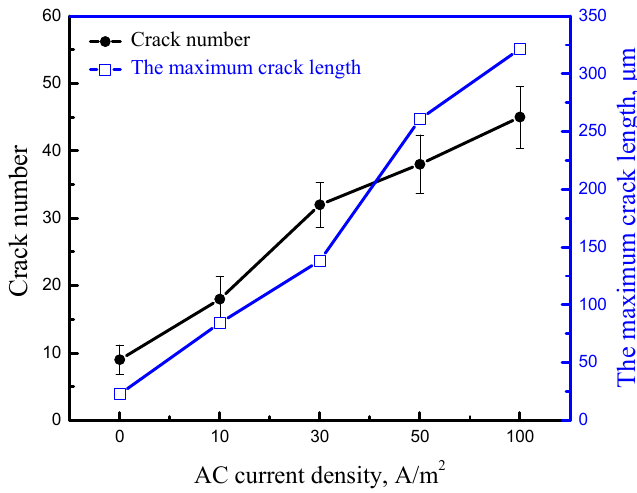
Figure 11. Number of cracks longer than 20 μ m and the maximum crack length on the side-surfaces of SSRT specimens obtained at various AC densities.